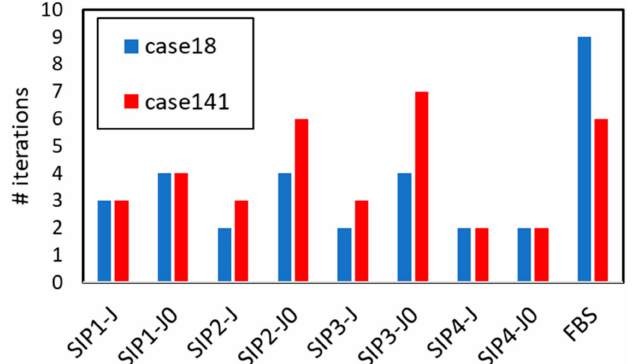
Figure 13. Total iterations employed in the various radial distributions test